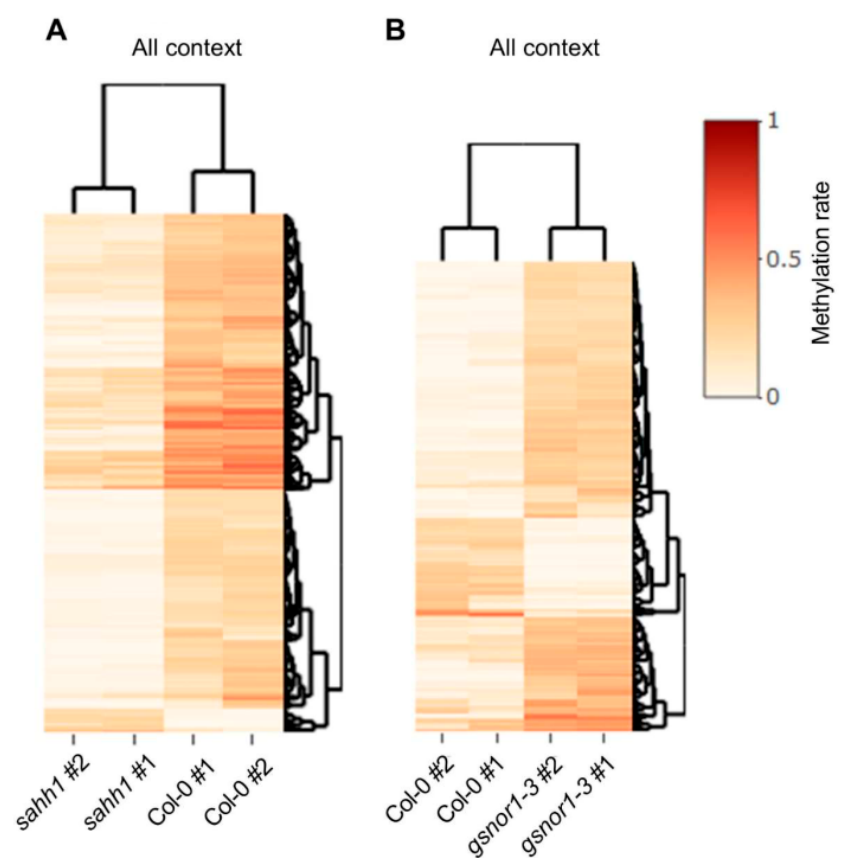
Figure 5. Enrichment of hypo- and hyper-DMRs in sahh1 and gsnor1-3 , respectively. Heatmaps of hierarchically clustered DMRs identified in pairwise comparisons of wt vs. sahh1 methylome ( A ) and wt vs. gsnor1-3 methylome ( B ). DNA was extracted from 4-week-old rosette leaves grown under long-day conditions, harvested 5 h after the day-time start, and subjected to WGBS. Heatmaps represent the methylation level across DMRs: red = 100% methylated, white = 0% methylated. Two biological replicates were analyzed for each genotype.